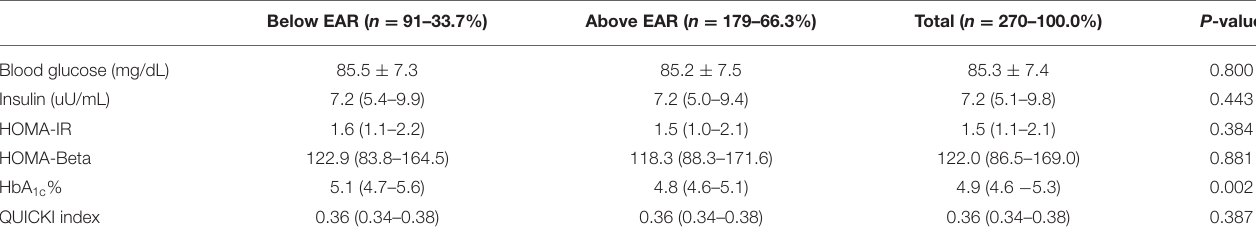
TABLE 2 | Biochemical characterization of individuals with Normal-Weight Obesity Syndrome, according to dietary selenium intake. Below EAR ( n = 91–33.7%) Above EAR ( n = 179–66.3%)